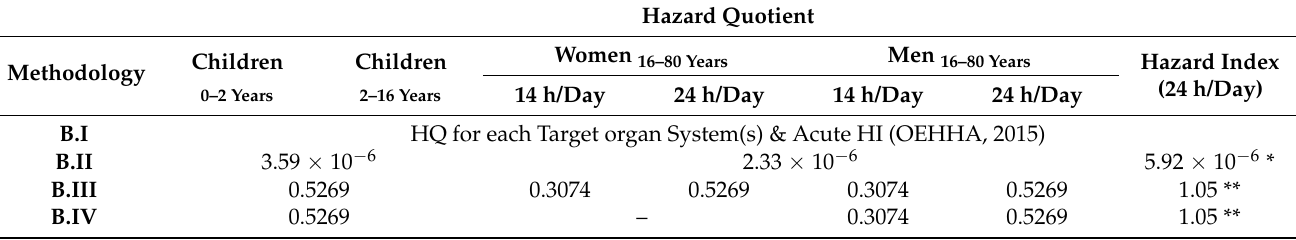
Table 6. Non-cancer risk assessment for Elefsina